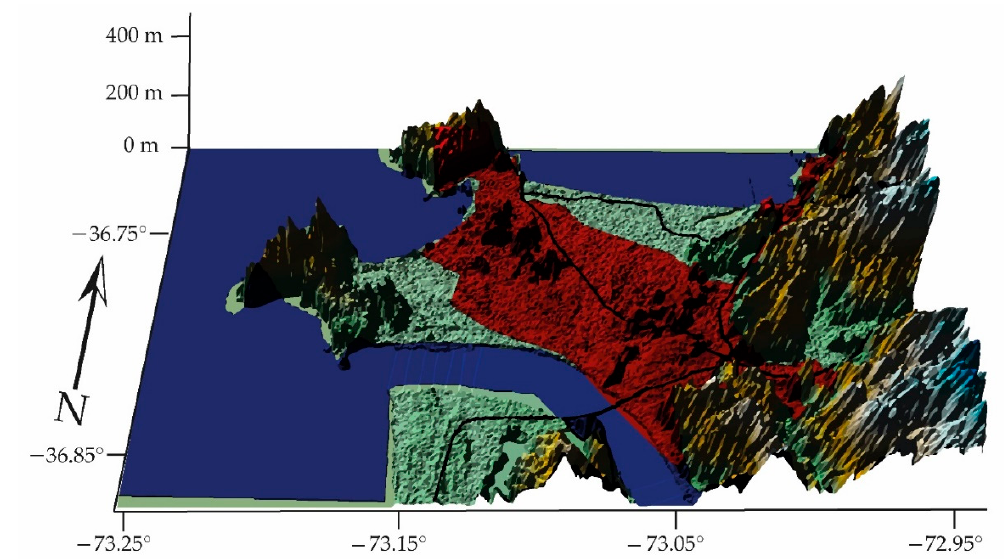
Figure 10. C K, Kingston College =0.88, the influence of the entropy of the contaminants is greater (GCS, WGS84).